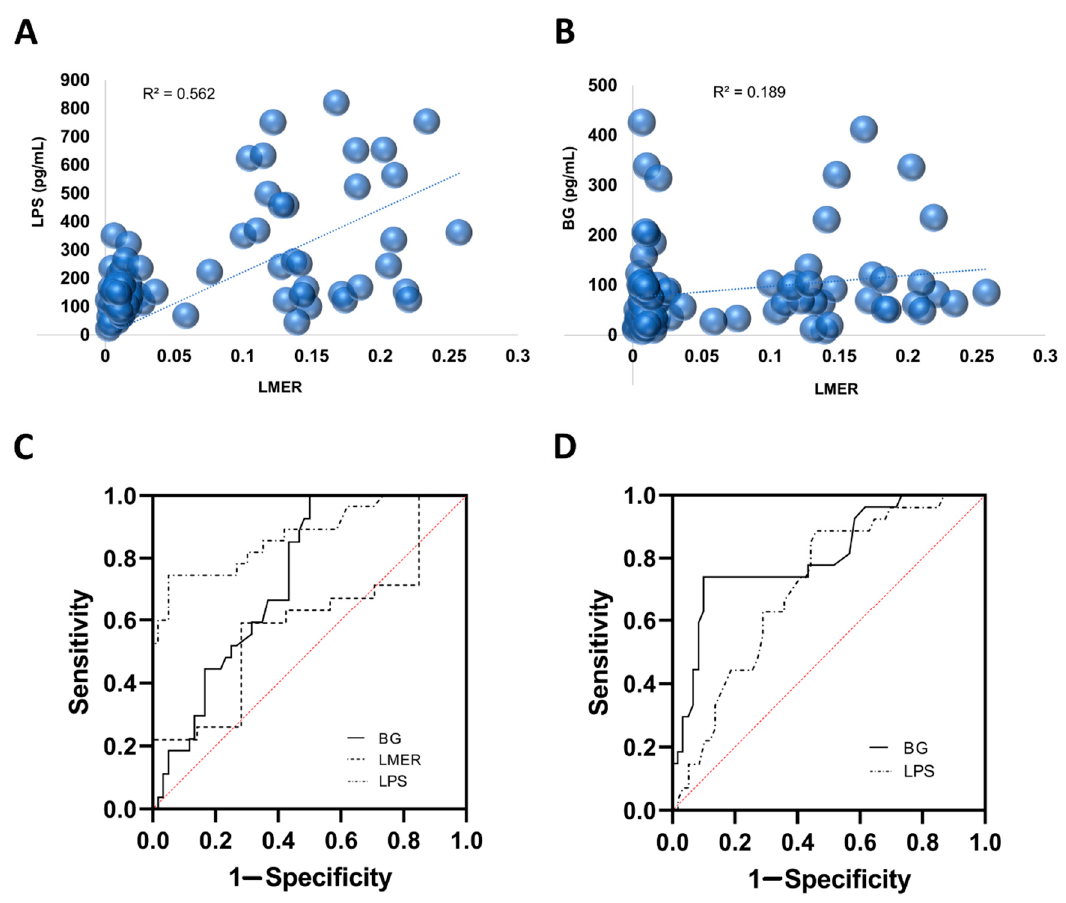
Figure 4. The relationship between the lactulose-to-mannitol excretion ratio (LMER) and serum lipopolysaccharides (LPS) and (1 → 3)- β -D-glucan (BG). ( A ) Increased LMER demonstrates a better correlation with serum LPS than ( B ) BG. The ROC (receiver operating characteristic) curves for ( C ) the severe dengue prediction of BG, LMER, and LPS and for ( D ) the severe dengue infection confirmation from BG, LMER, and LPS are shown. Table 3. Parameters calculated by ROC curves of the lactulose-to-mannitol excretion ratio